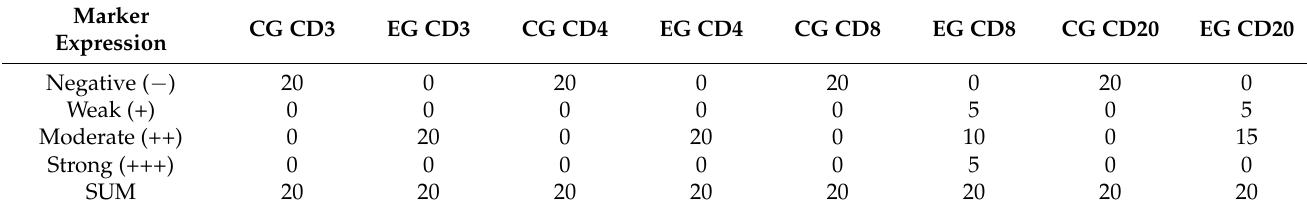
Table 2. CD3, CD4, CD8, and CD20 antigen expression intensity in the decidua parietalis.